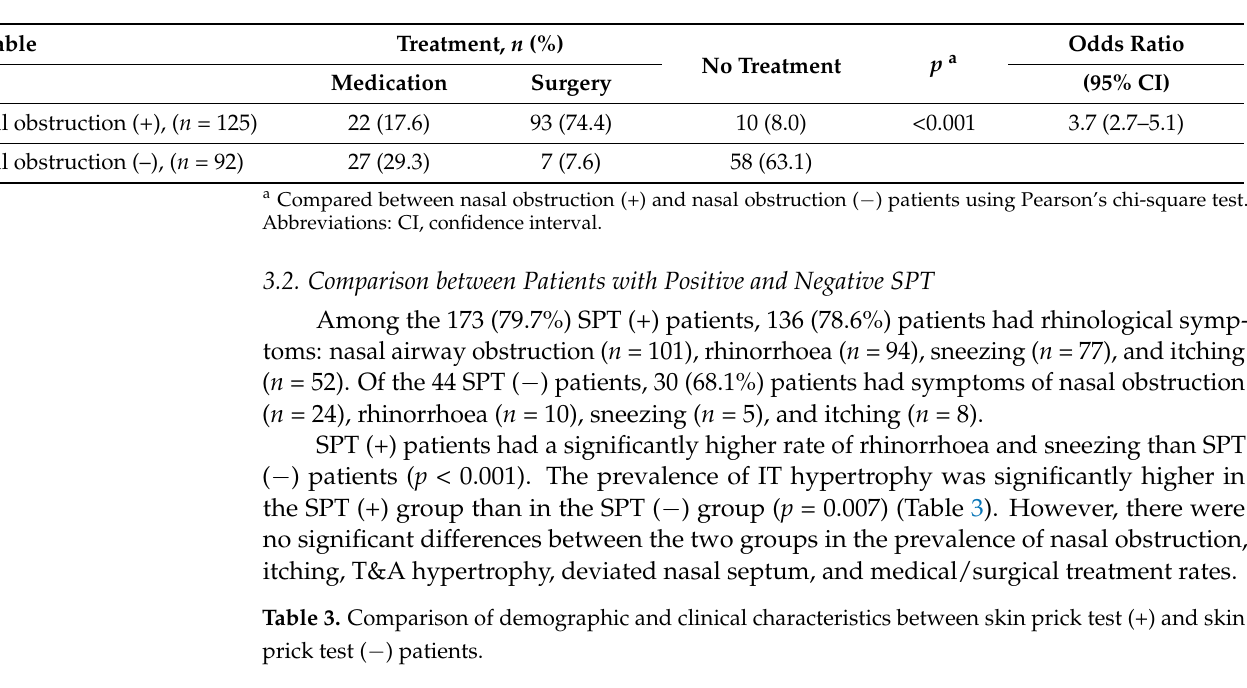
Table 2. Treatments performed in patients with and without nasal obstruction.